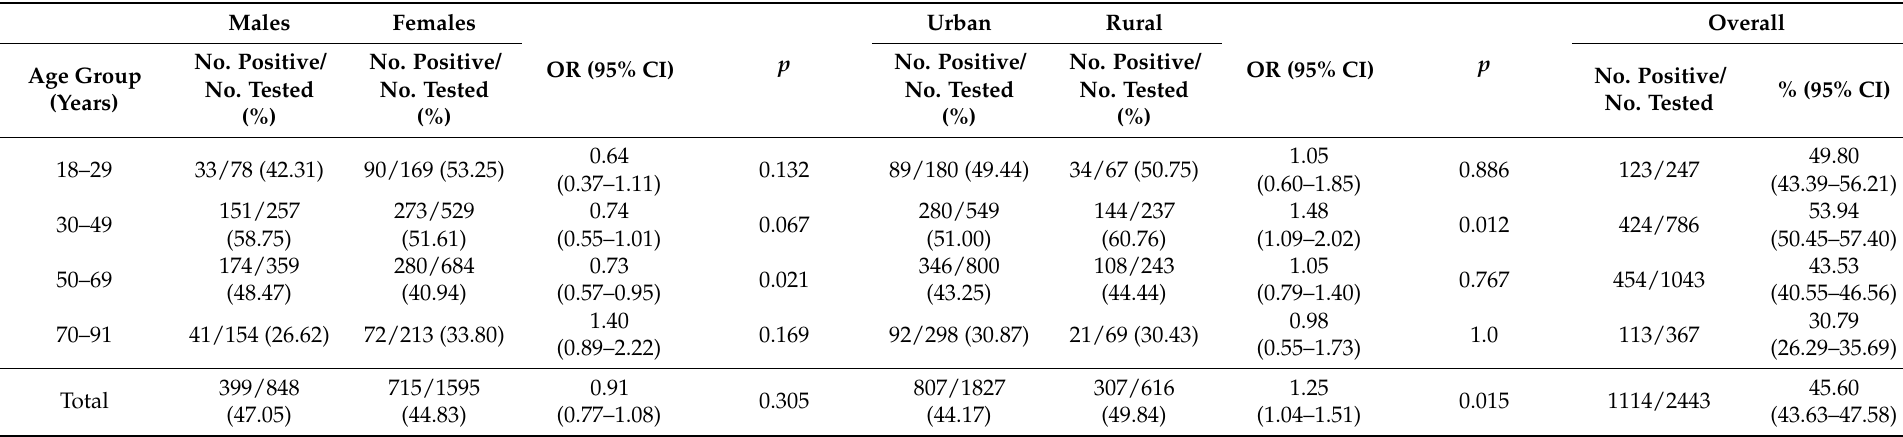
Table 1. Seroprevalence of SARS-CoV-2 among adults ( n = 2443) in Western Romania according to age, gender, and area of